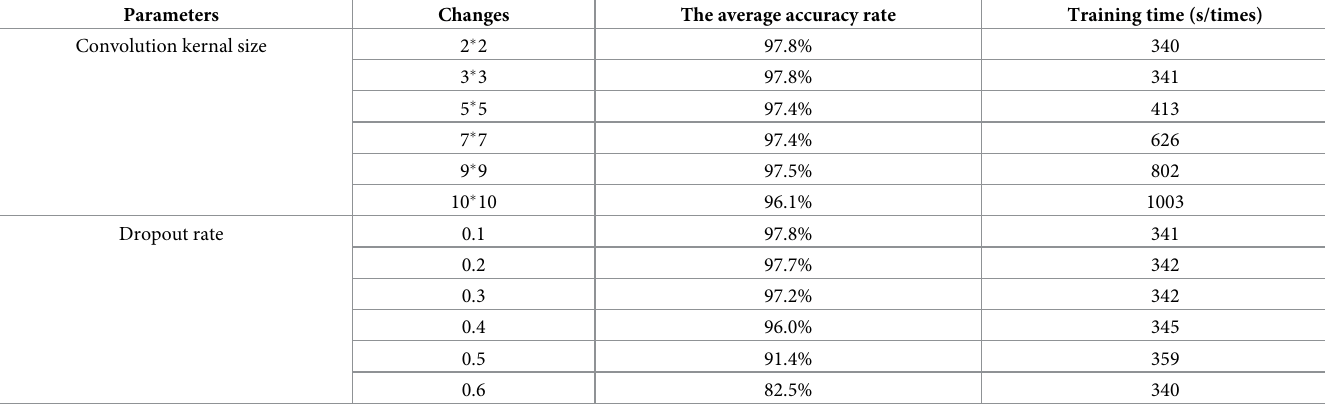
Table 2. The influence of different parameters on the recognition efficiency of MS-CNN model. Parameters